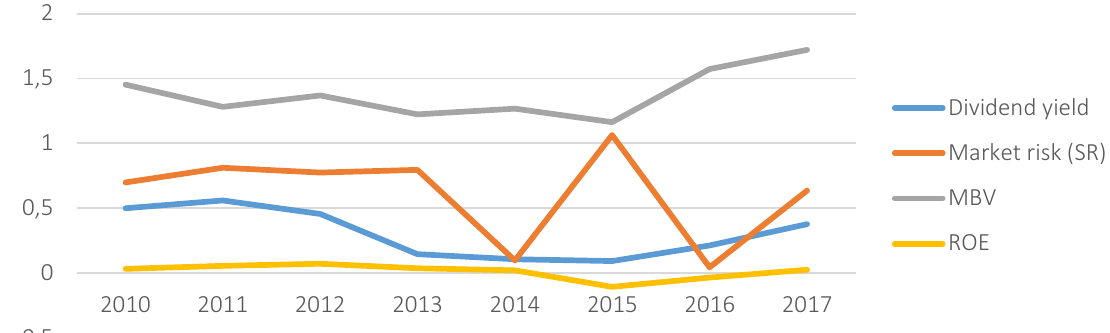
Figure 5. Mean (A4) of dividend yield, stock beta, MBV, and ROE